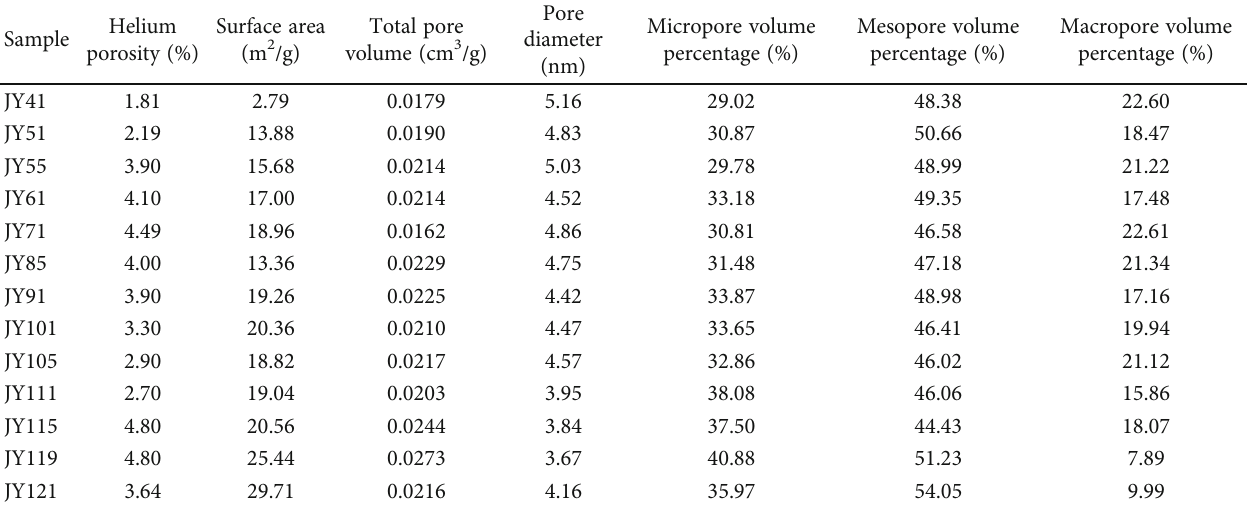
Table 2: Pore structure parameters of the investigated marine shale